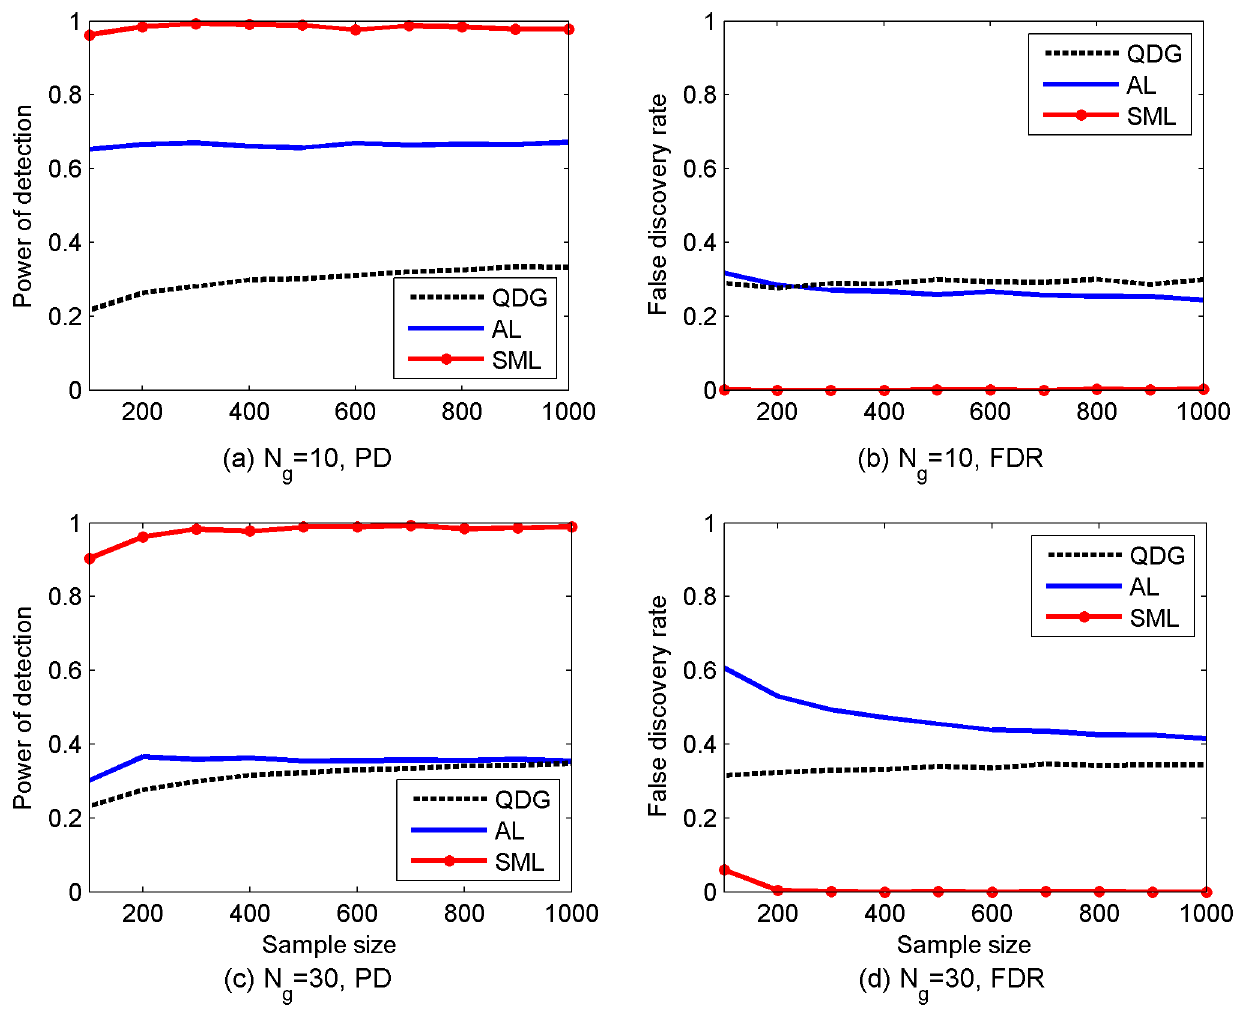
Figure 2. Performance of SML, AL and QDG algorithms for directed acyclic networks of N g ~ 10 [(a) and (b)] or 30 [(c) and (d)] genes. Expected number of nodes per node is N e ~ 3 . PD and FDR were obtained from 100 replicates of the network with different sample sizes ( N ~ 100 to 1,000).